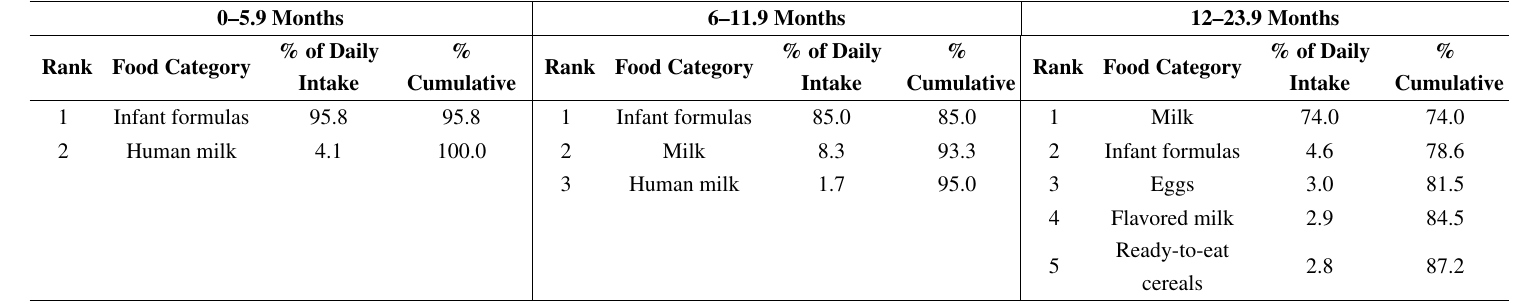
Table 12. Food sources of Vitamin D among US infants and toddlers aged 0–23.9 months by age group: NHANES 2005–2012 ( n = 2740) a